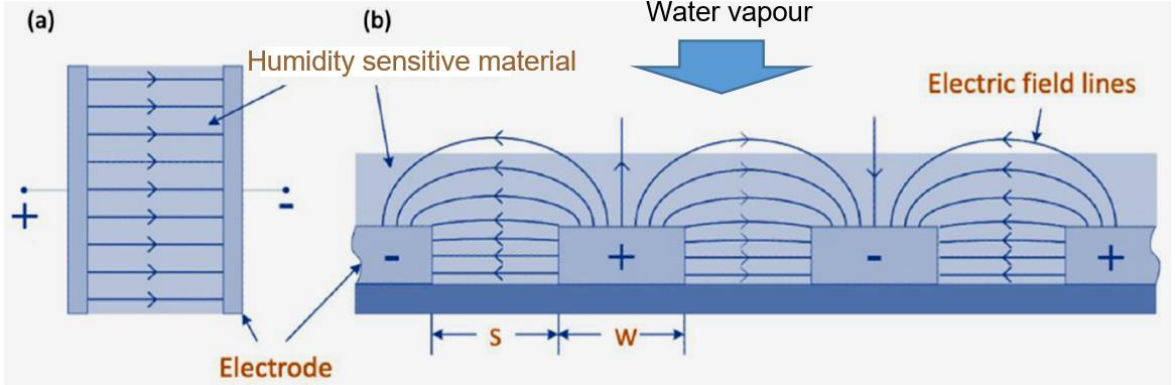
Figure 11. ( a ) Parallel plate capacitor; ( b ) coplanar interdigital sensors and electric field distribution in them. Adapted from [257]. Published 2015 by MDPI as open access.